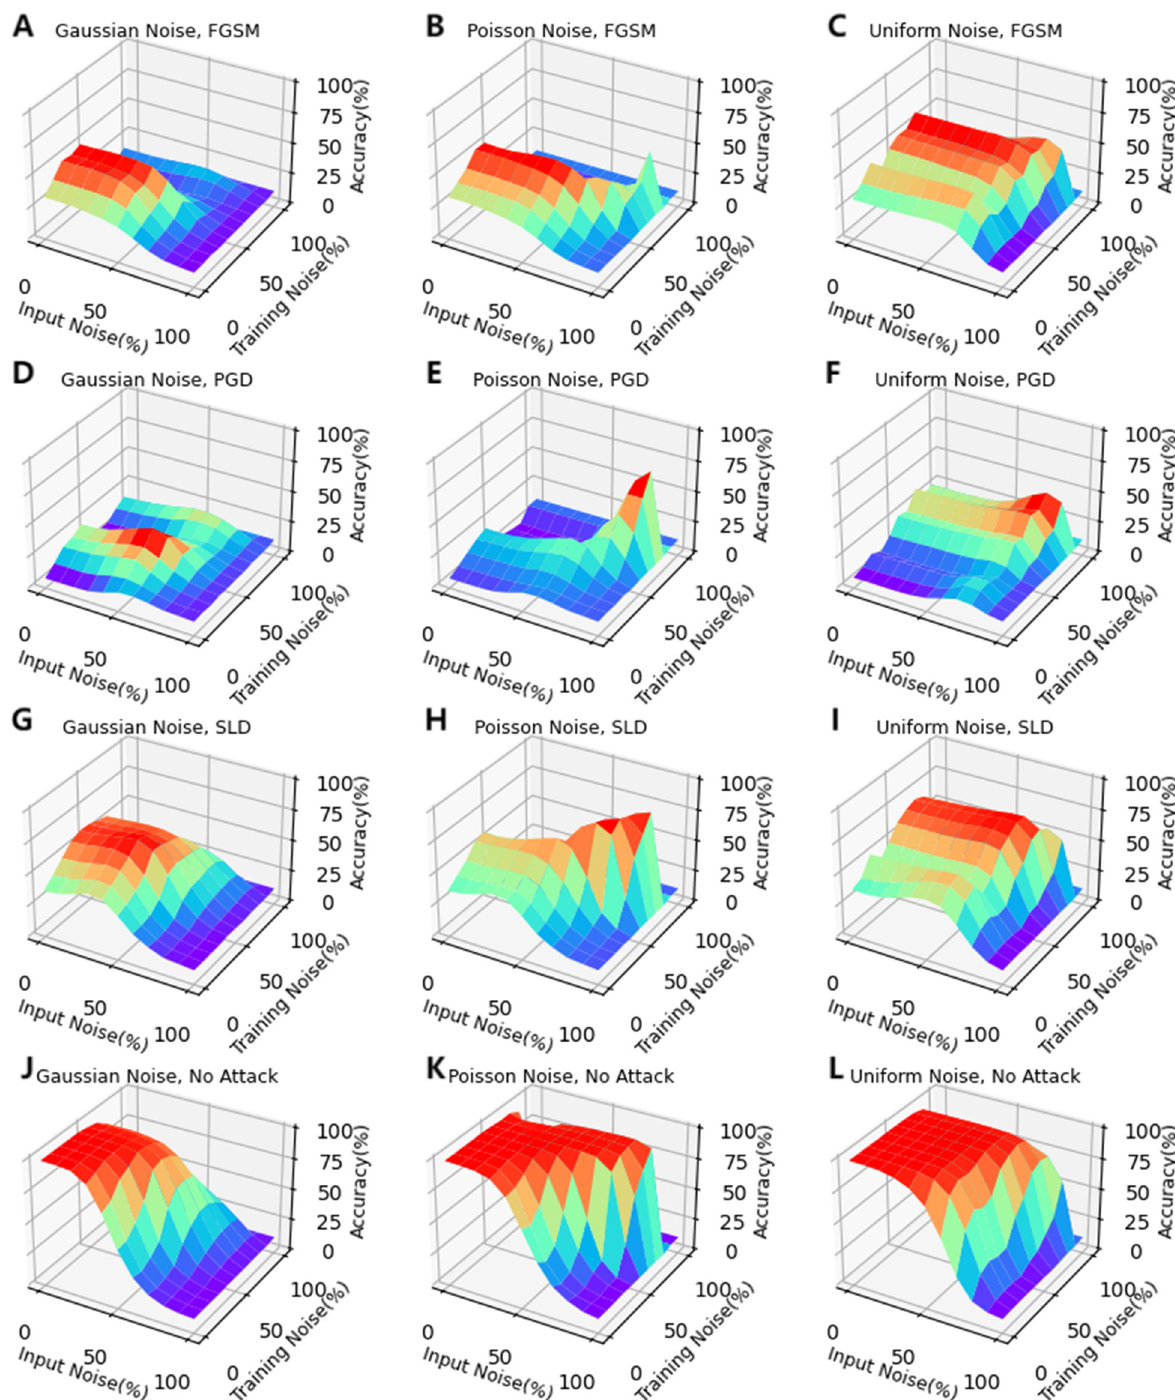
Figure 2. Accuracy of the MNIST. The x and y axes are the amplitudes of the training noise added during training time and the input noise added at running time, respectively. The z axis represents the accuracy of the corresponding noise conditions.